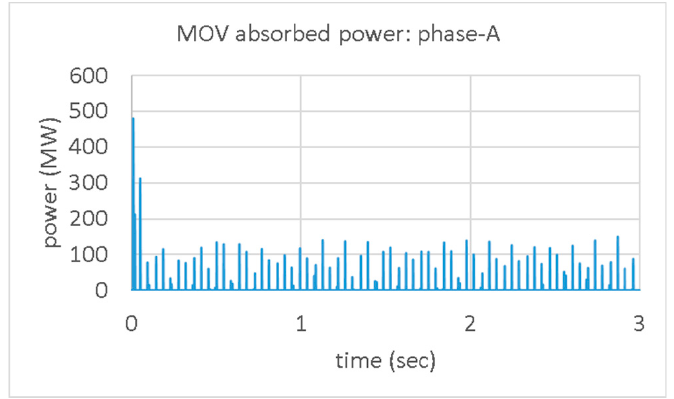
Figure 21. Absorbed power of MOV.